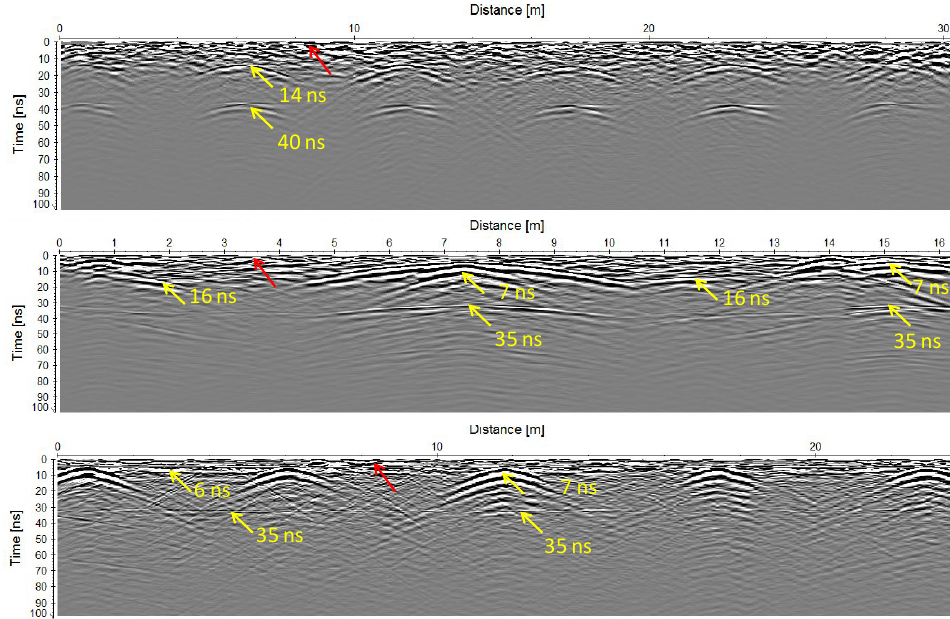
Figure 6. Radar sections recorded with the “medium antennae” of the GPR-R prototype system in the cathedral: L 7 (upper panel), L 13 (middle panel), L 4 (lower